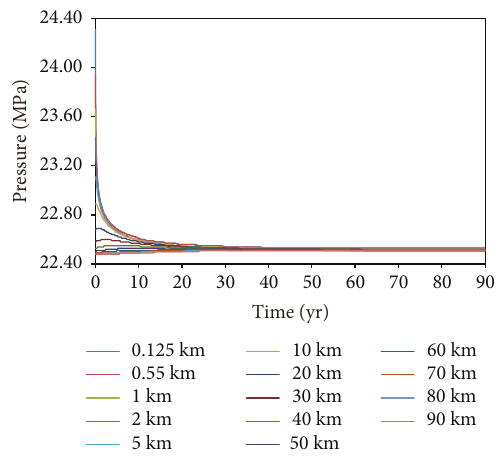
Figure 13: Pressure changes at pressure monitoring points after the cessation of CO 2